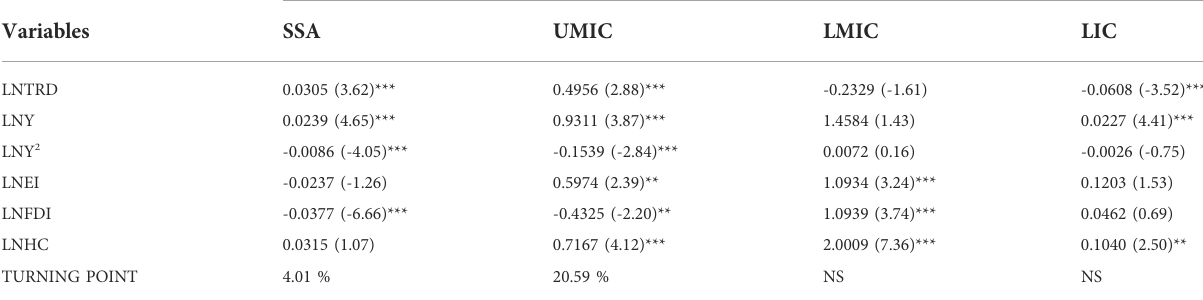
TABLE 4 Environmental Kuznets Curve (EKC)